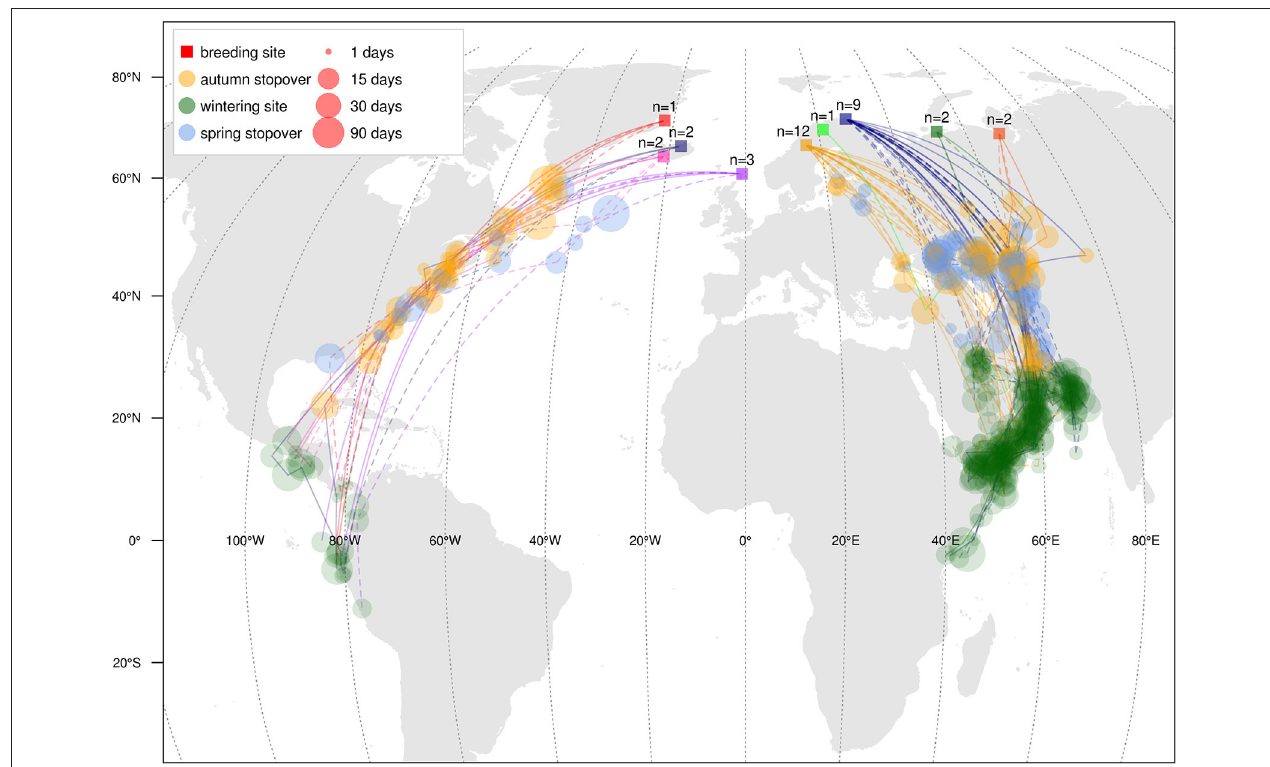
FIGURE 1 | Autumn (solid lines) and spring (dashed lines) migration stopovers and wintering areas of individual Red-necked Phalaropes derived from light-level geolocator tracks. Colored squares show the nine breeding sites (with corresponding sample sizes, i.e., tracked individuals). Dot size represents staging duration. Staging dots are connected by great-circle lines, which do not necessarily represent the exact routes